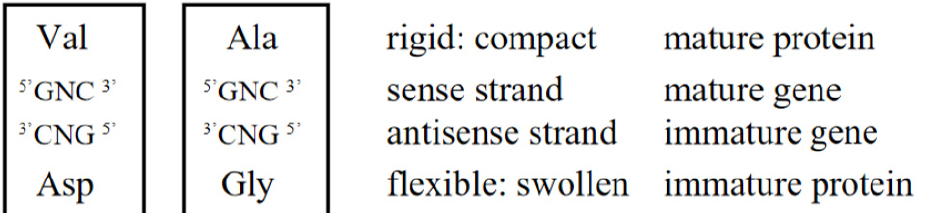
Figure 6. Four GNC codons were assigned to four [GADV]-amino acids frozen-accidentally. However, the assignment was not completely random. Two contrasting amino acid pairs (Val-Asp and Ala-Gly) were assigned to two complementary codon pairs (GUC-GAC and GCC-GGC) so that a rigid and compact mature [GADV]-protein could be formed from a flexible and swollen immature [GADV]- protein. That is, it is supposed that an immature [GADV]-protein composed of Asp and Gly at higher rates than Val and Ala evolved to a mature [GADV]-protein as accumulating amino acid replacements from Asp to Val and from Gly to